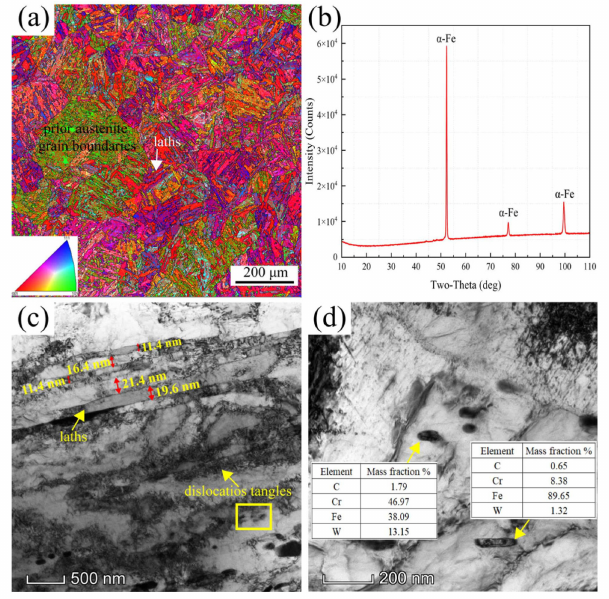
Figure 2. The microstructure of the MarBN steel: ( a ) Inverse polo figures plus GBs; ( b ) image of the XRD analysis results; ( c ) TEM of the microstructure; and ( d ) enlarged view of the yellow rectangle in ( c